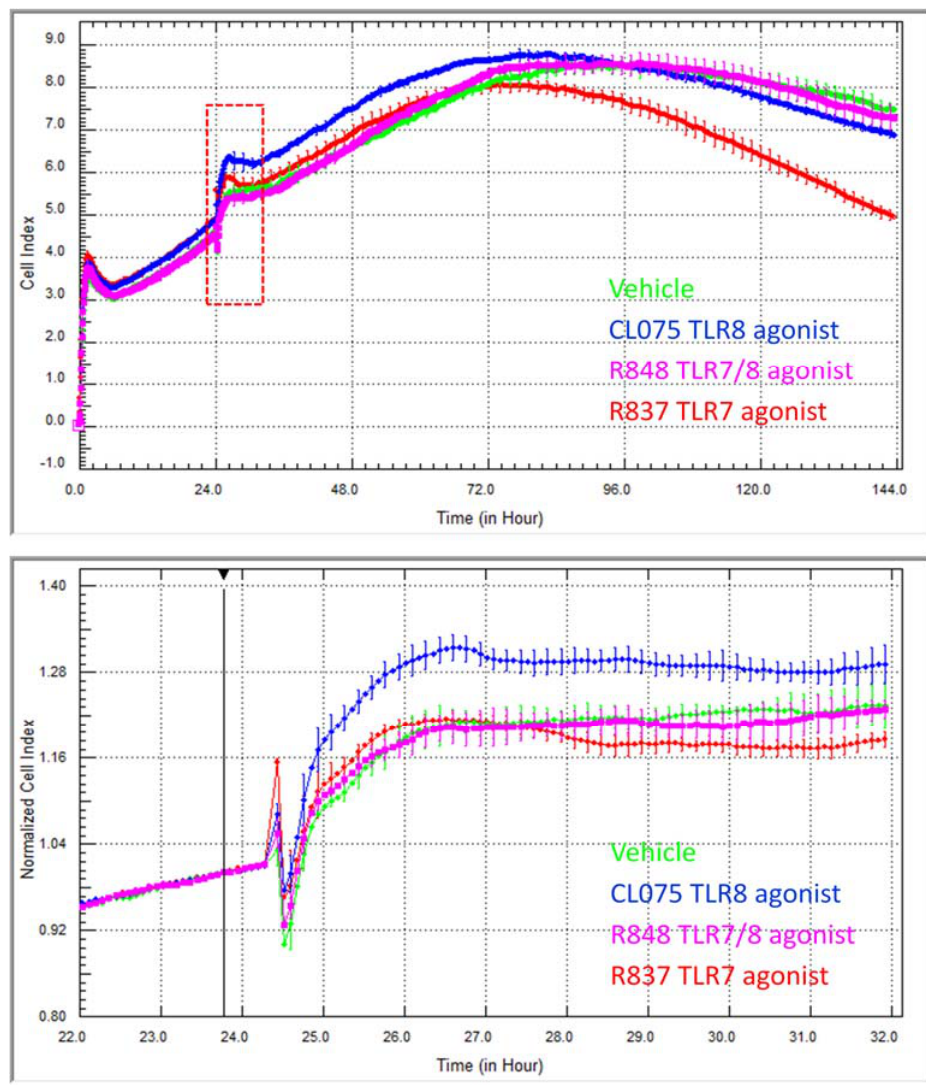
Figure 8. xCELLigence reveals the differential temporal responsiveness of skin endothelial cells to various TLR ligands across a six-day time course. CL075 (5 μ g/mL) induces an immediate and sustained increase in endothelial adhesion, whereas the R837 (5 μ g/mL) effects are not obvious until at least 48 h after drug addition. The cells did not appear to respond to R848 (10 μ g/mL). The black arrow indicates the time of TLR agonist addition, and the acute response period, highlighted by the red box, is shown in the lower panel. The lower panel reveals clearly the immediacy of the CL075 response. Each curve represents the mean of four wells ± SD. Note that the lower panel is normalised to the time of drug